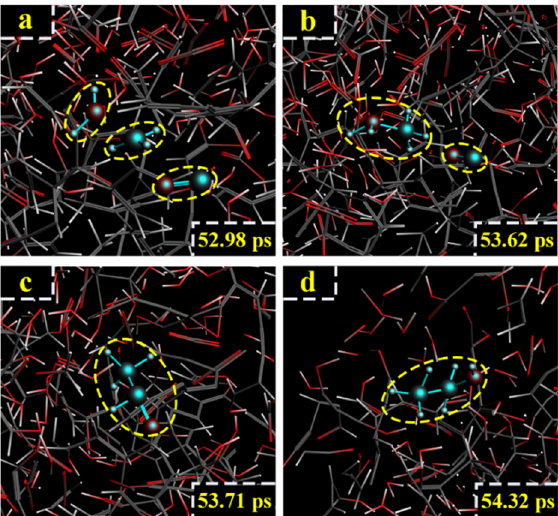
Figure 19. Path V for the production of ethanol. ( a – d ) are the procedure of LGA to produce ethanol at 2800 K.